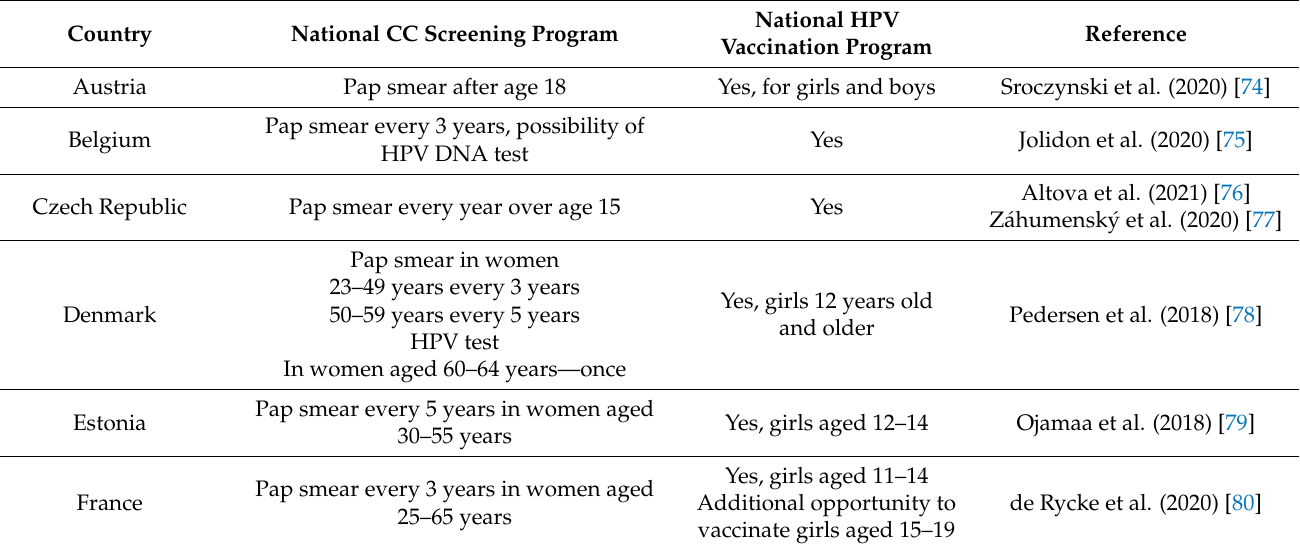
Table 2. Implementation of CC prevention programs in selected European